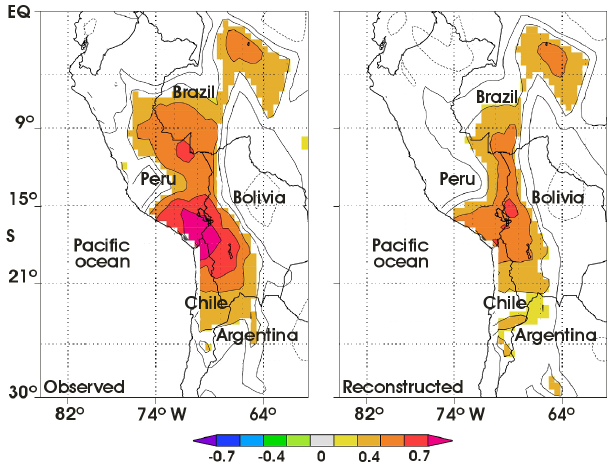
Fig. 3. Spatial correlation field between the CRU 3.1 0 . 5 × 0 . 5 ◦ gridded November–October precipitation and our regional instrumental precipitation series for the Central Andes (see Ta- ble 1) (a) , and the Altiplano reconstructed November–October pre- cipitation (b) for the 1961–2006 period (only significant correla- tions are